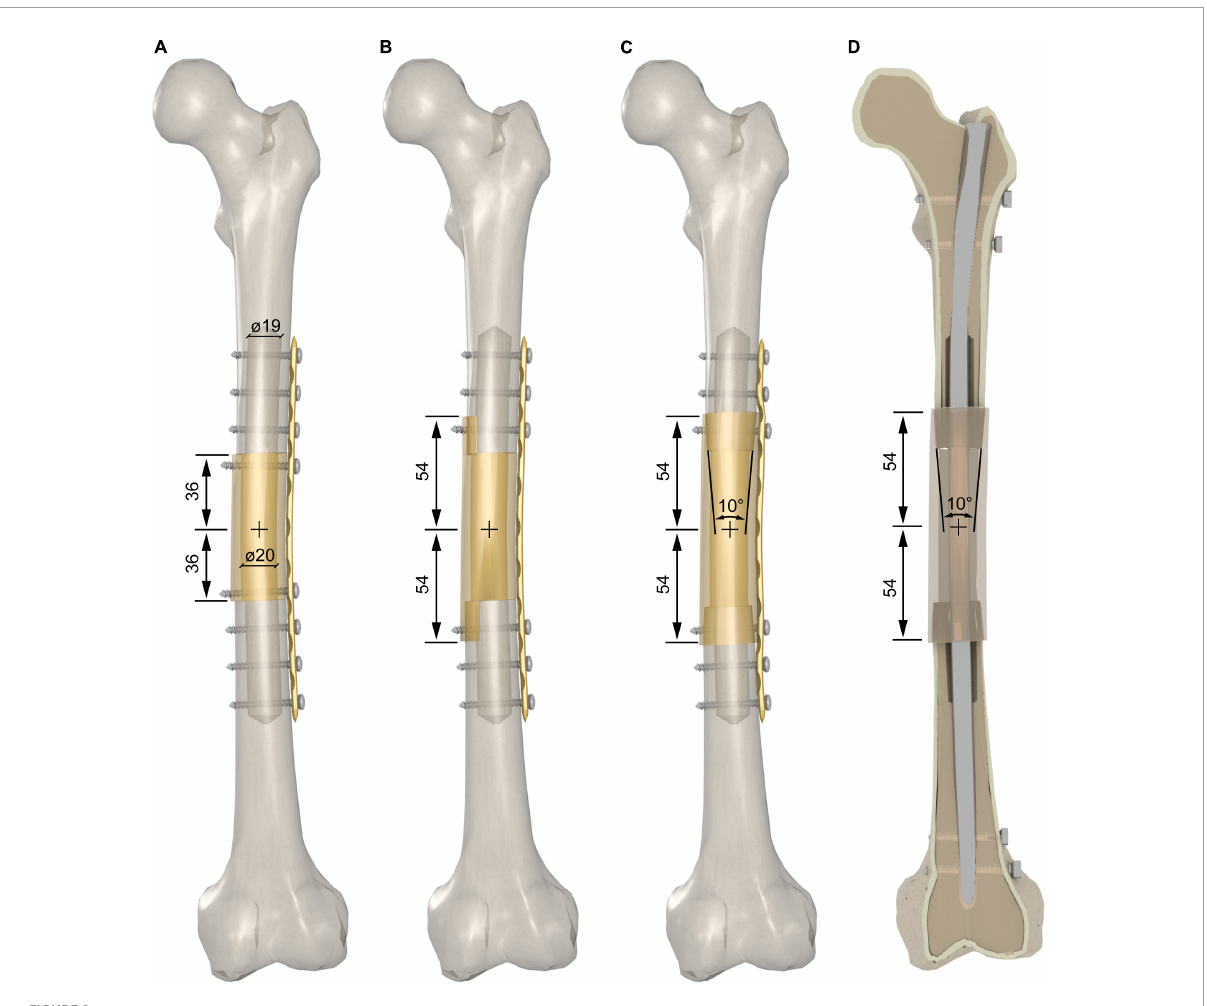
FIGURE2 (A) End-to-end junction reconstruction with bone plate fixation. Two additional cortex screws were added to fix the massive graft. (B) Modified step-cut junction reconstruction with bone plate fixation. (C) Taper junction reconstructions with bone plate fixation; (D) taper junction reconstructions with intramedullary nail